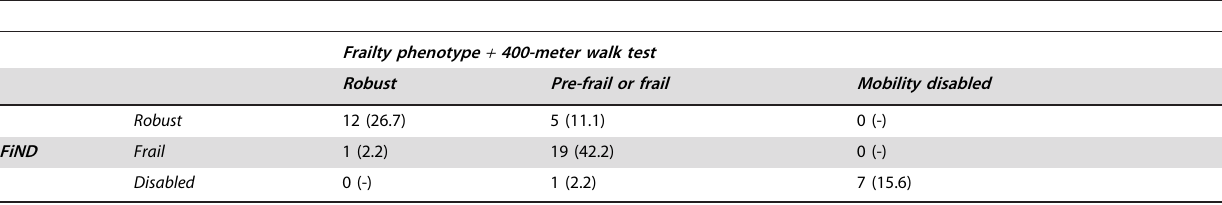
Table 3. Comparison of results from the FiND questionnaire with those obtained from the frailty phenotype and 400-meter walk test.